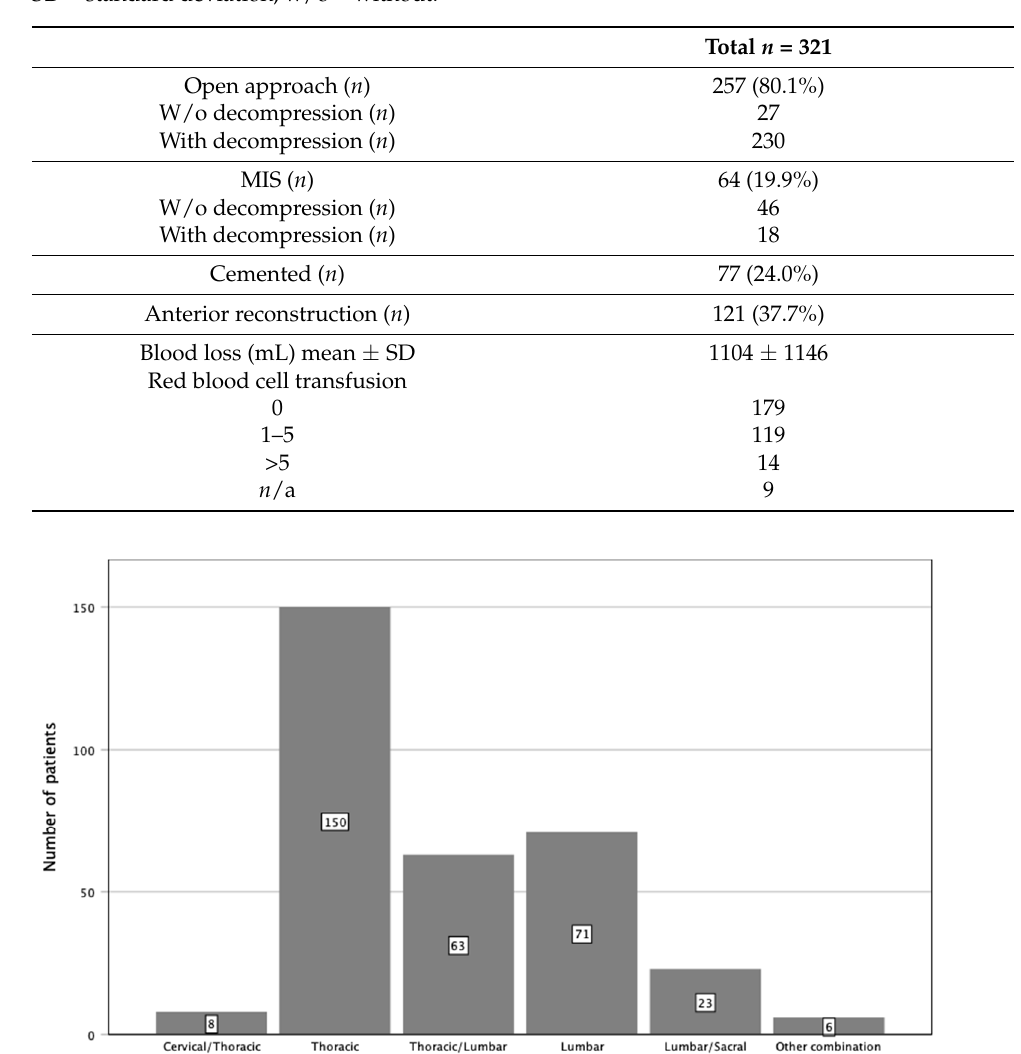
Figure 3. Localization of instrumentation stratified by spinal sections.